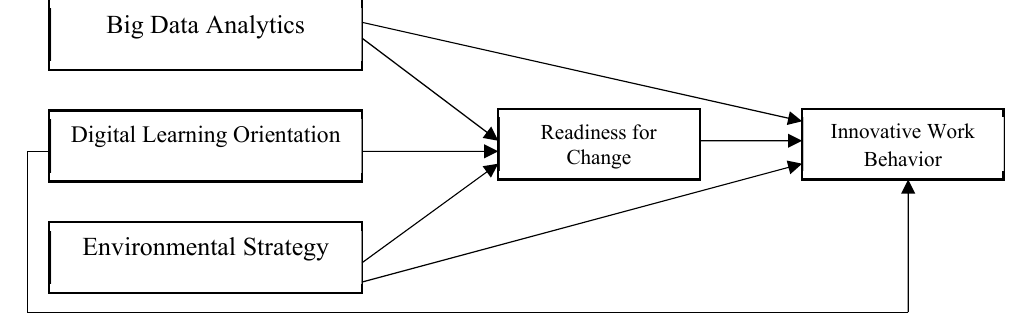
Fig. 1. Theoretical